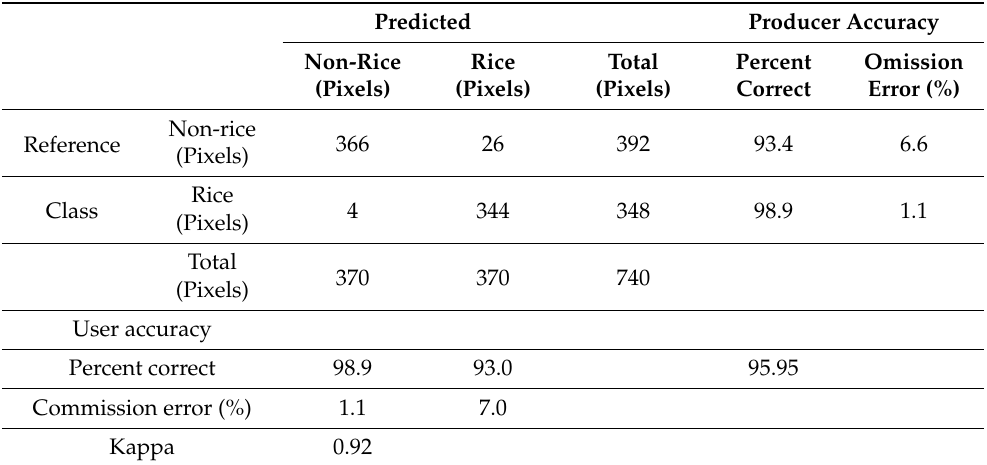
Table 2. Confusion matrix for the rice classification in Peninsular Malaysia by this